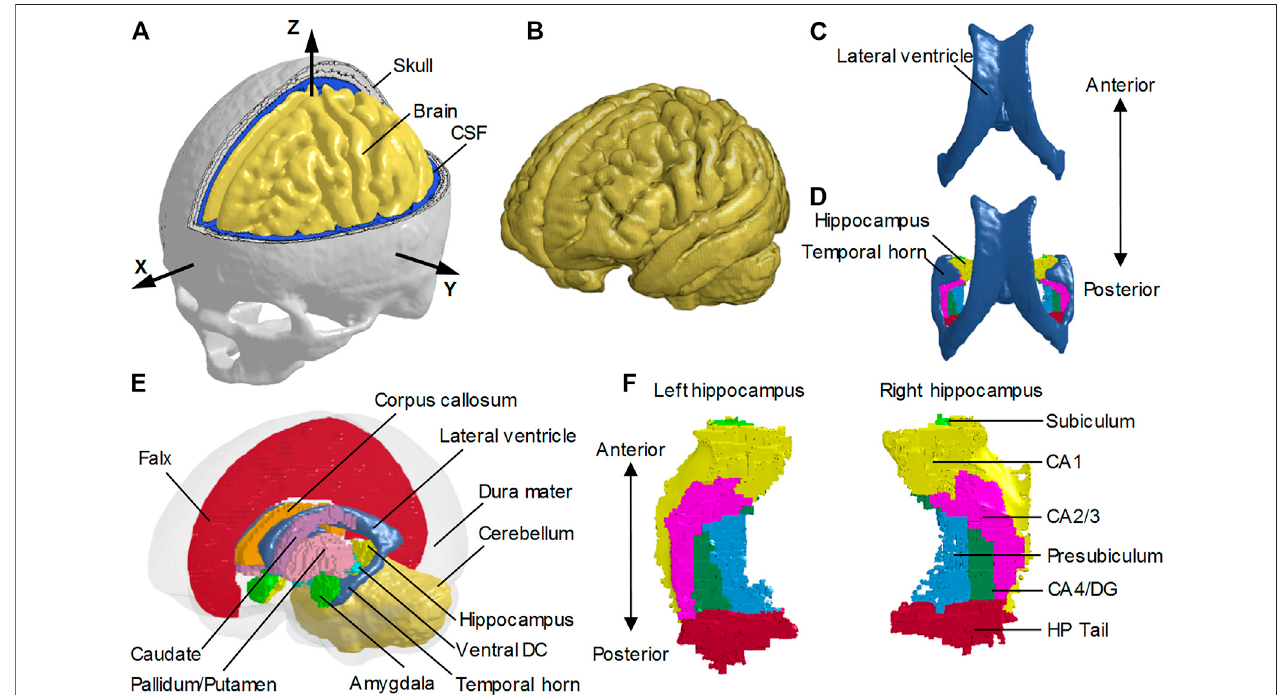
FIGURE1| Finiteelementmodelsofthehumanheadwithandwithoutthetemporalhorn. (A) HeadmodelwiththeskullopentoexposethesubarachnoidCSFand brain. A skull- fi xed coordinate system and corresponding axes are illustrated with the origin at the center of gravity of the head. (B) Brain model with fi ne mesh. (C) Ventricles (i.e., lateral ventricles without the temporal horn, and third ventricle) in the NTH-model. (D) Ventricles (i.e., lateral ventricles with the temporal horn, and third ventricle)intheTH-modelandhippocampus. (E) Isometricviewofdeepbrainstructures,cerebralventricles,falx,andduramater(intranslucency)intheTH-Model. (F) Left and right hippocampal formations with sub fi elds. CSF: cerebrospinal fl uid; Ventral DC: ventral diencephalon; CA: cornu ammonis; DG: dentate gyrus; HP Tail: hippocampal tail.